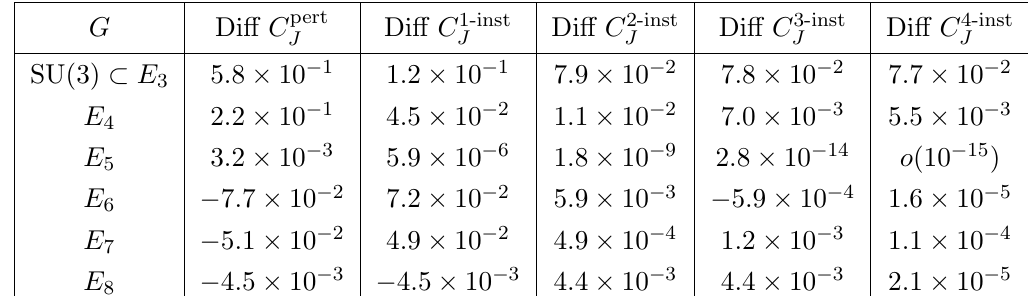
Table 5. The di(cid:11)erences between the values of the (cid:13)avor central charge C G the fundamental hypermultiplet masses and using the instanton particle mass, at each instanton number in the rank-one Seiberg exceptional